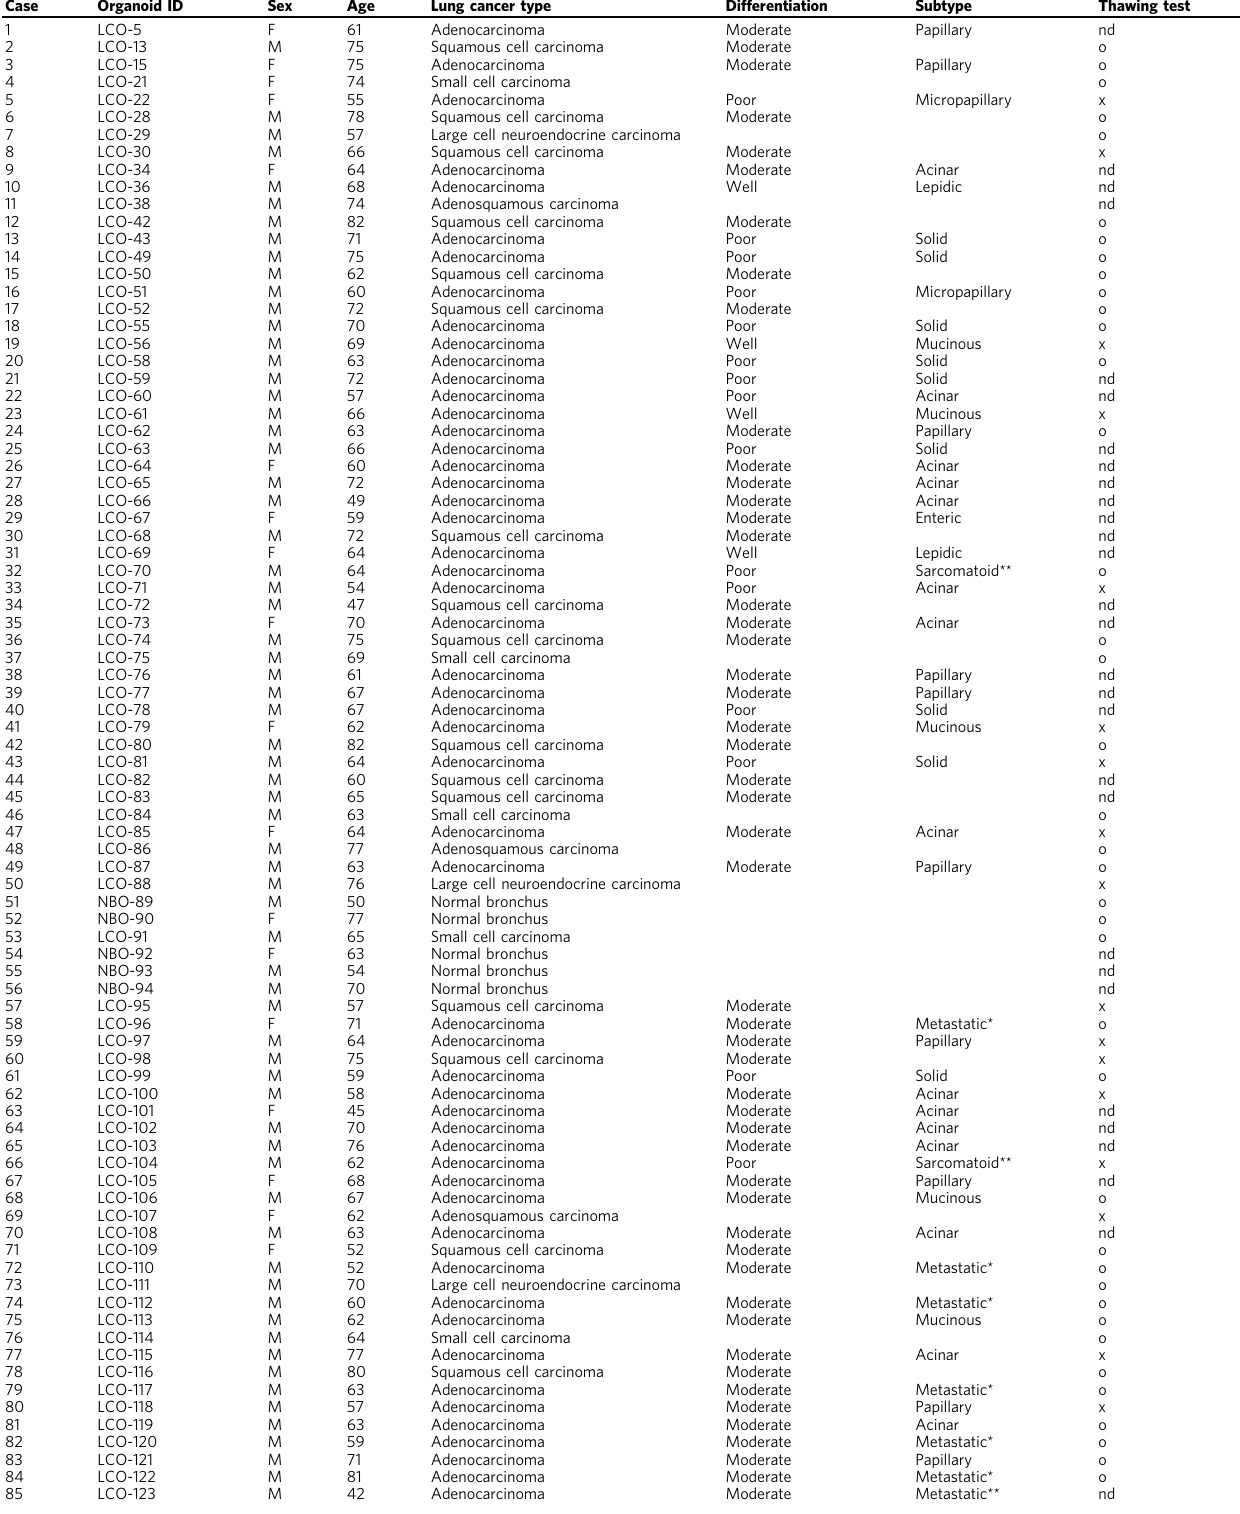
Table 2 The list of lung cancer organoids and normal bronchial organoids in the orgnoid biobank